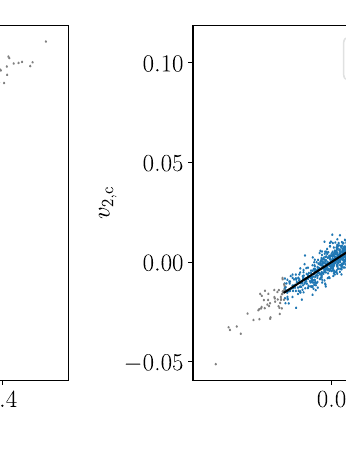
our analysis, while the other colors correspond to the 5 bins in which the statistical properties are investigated independently (see main